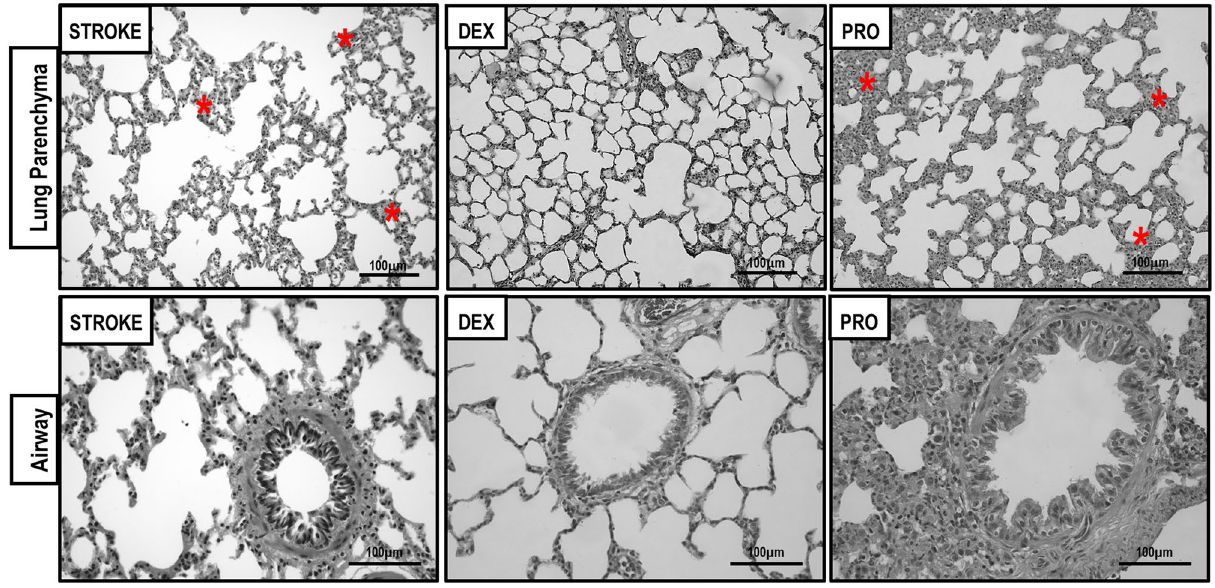
Figure 1. All animals were submitted to focal ischemic stroke. 24-h later, they were randomly assigned, by sealed envelopes, to (1) Group STROKE; (2) Group DEX; and (3) Group PRO. After 1-h of anesthetic infusion, lungs were removed for histology analysis. Representative images of lung parenchyma upon autopsy in STROKE group (only stroke without dexmedetomidine or propofol infusion), after dexmedetomidine and propofol infusion (superior panels, × 200) and airway (inferior panels, × 400). Note the atelectasis (red asterisks) in the STROKE and PRO groups. The airway lumen in STROKE and PRO groups was constricted compared to DEX group. Scale bar = 100 μm.